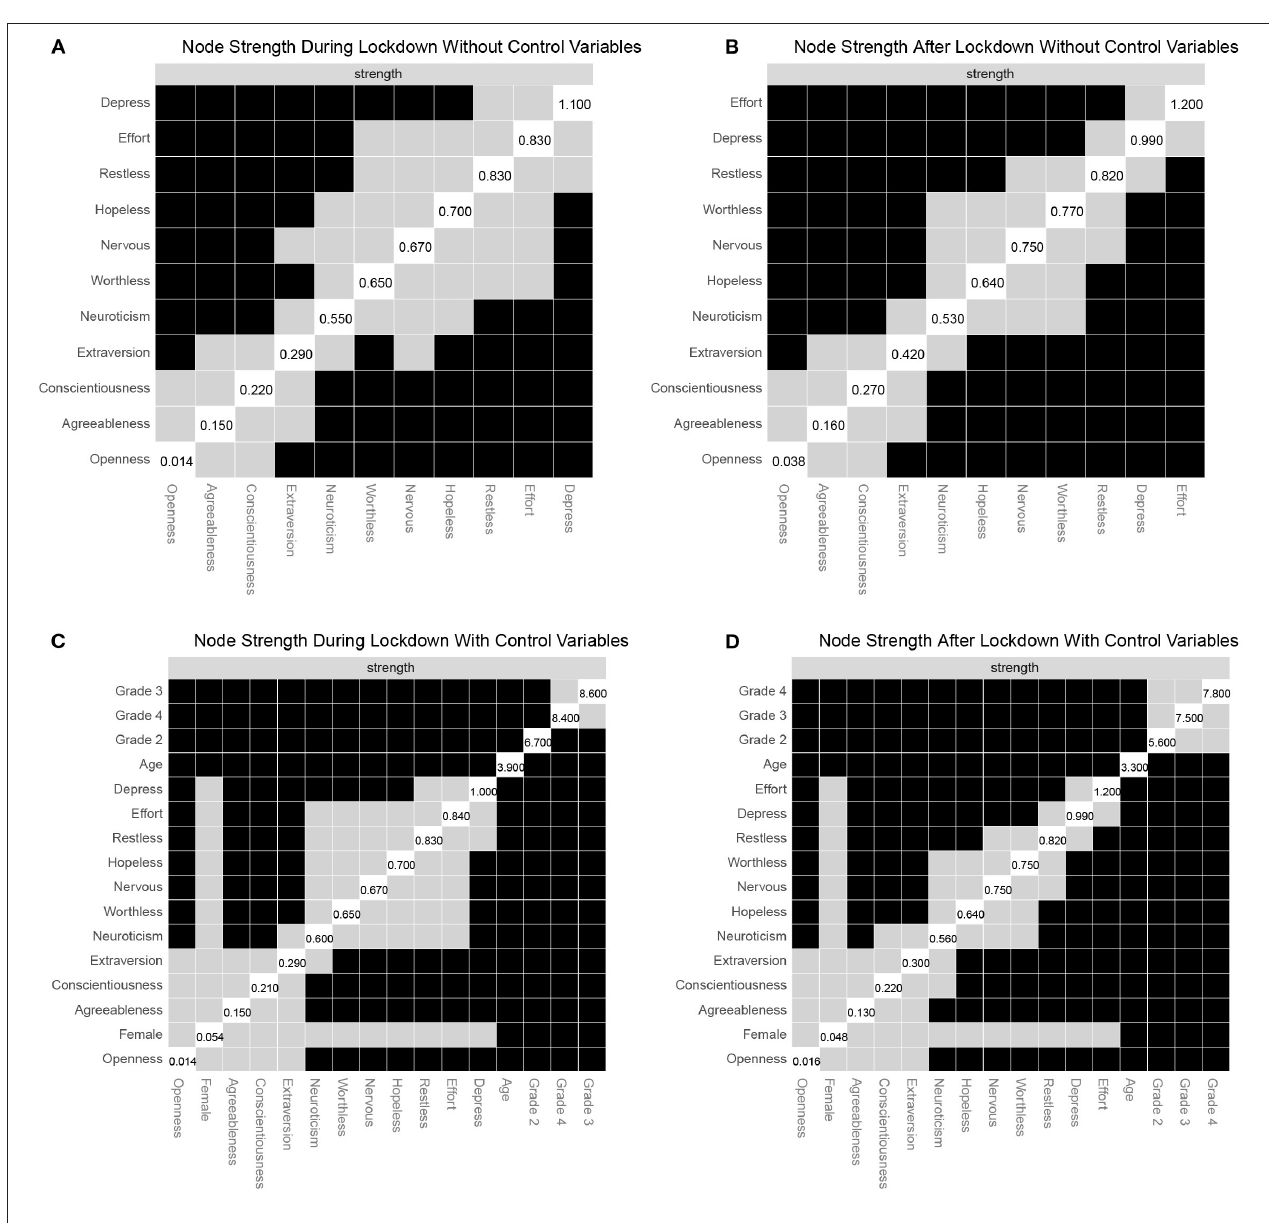
FIGURE 4 | Strength results and non-parametric bootstrapped difference test for strength centrality. Values reported in the diagonal represent the values of strength centrality for each node. Gray boxes denote no difference between nodes, while black boxes indicated significant difference. (A) Node strength during lockdown without control variables. (B) Node strength after lockdown without variables. (C) Node strength during lockdown with control variables. (D) Node strength after lockdown without